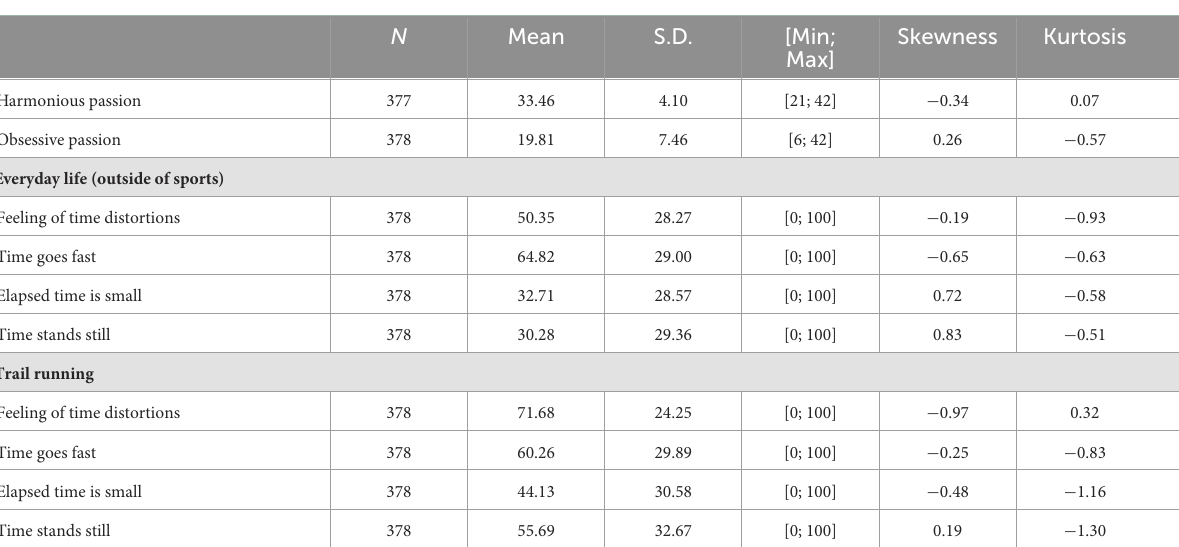
TABLE 1 Descriptive